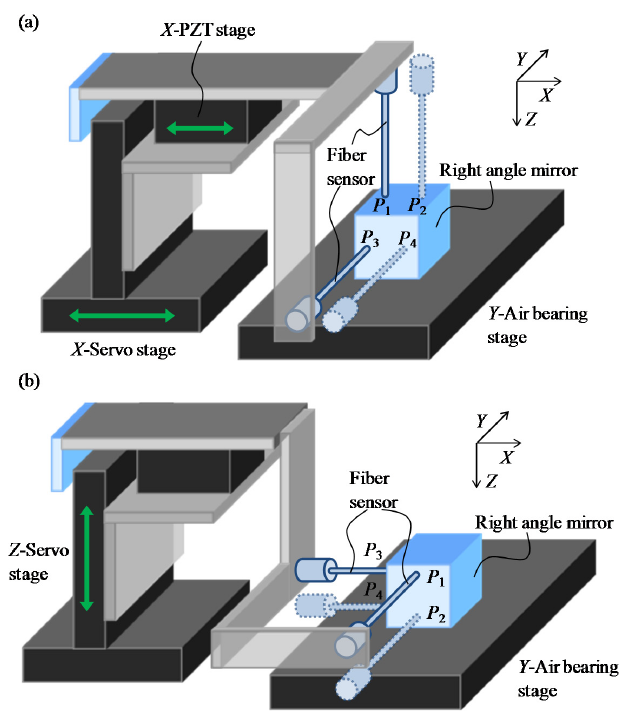
Figure 6. Schematic for evaluation of the angular alignment errors: ( a ) X ‐ directional stages; ( b ) Z ‐ directional stage.